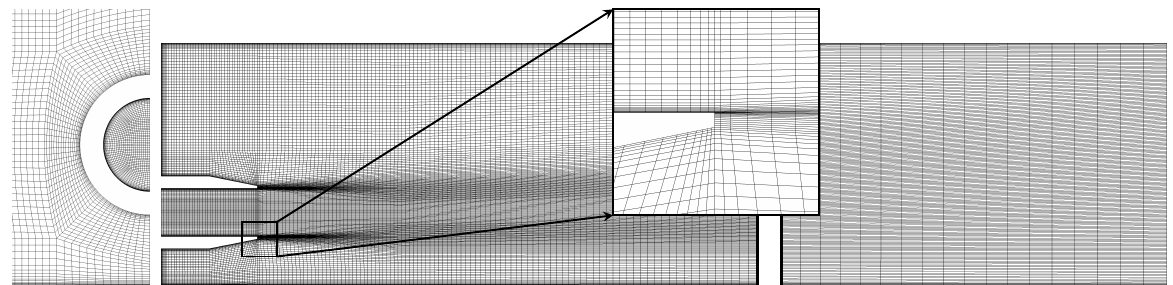
Figure 3. Various views of the computational mesh. Left: close-up of mesh around inlet, right: overview of mesh at symmetry plane at inlet and outlet with close-up at the jet nozzle.